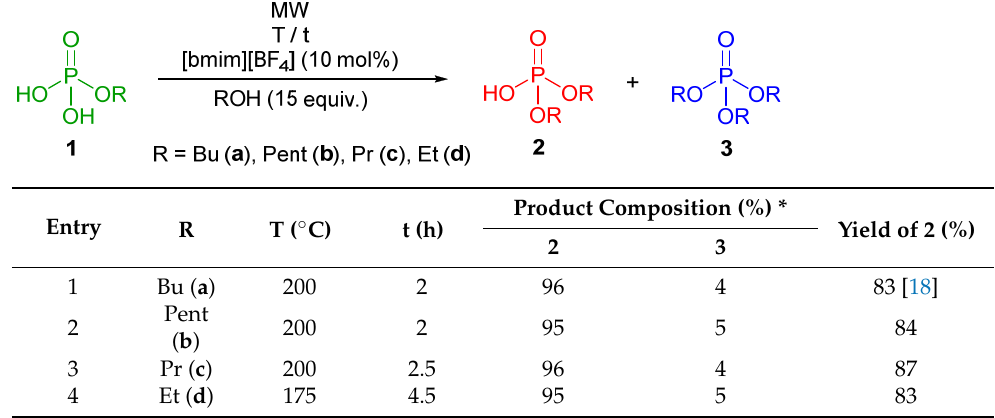
Table 1. Direct esterification of monoalkylphosphates ( 1 ) with MW irradiation under different conditions.